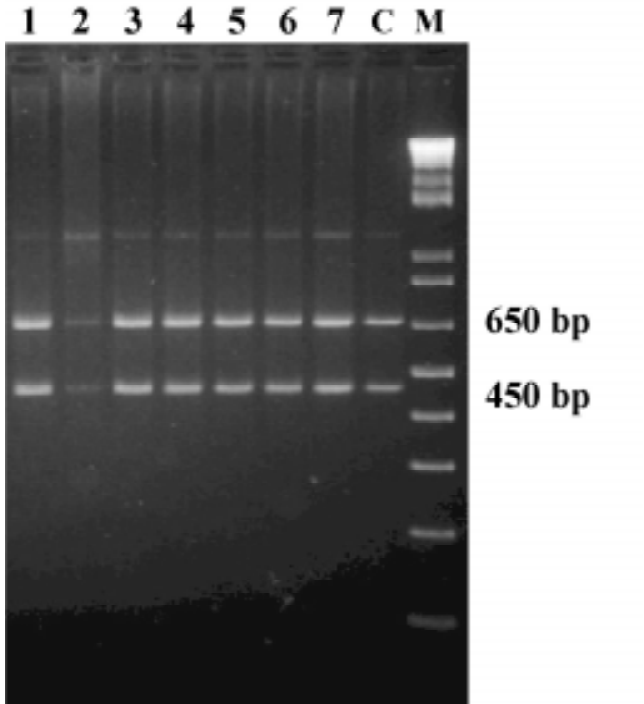
Fig. 1. Restriction fragment polymorphism analysis of PCR-amplified 16S rDNA from Elm Yellows phytoplas- mas extracted from various organs of hybrid Lobel elm trees. After amplification with primers R16(V)F1/R1 the PCR-products were digested with endonuclease Bfa I and resolved by agarose gel electrophoresis. Lanes: 1, flow- ers; 2, anthers; 3, ovaries; 4, unripe seeds; 5, ripe seeds; 6, membranaceous wings; 7, ripe seeds. Lane C, posi- tive control, using as template the DNA from phytoplas- ma strain SRL14. Lane M, 1 kb Plus DNA ladder (Gib- co-BRL, Life